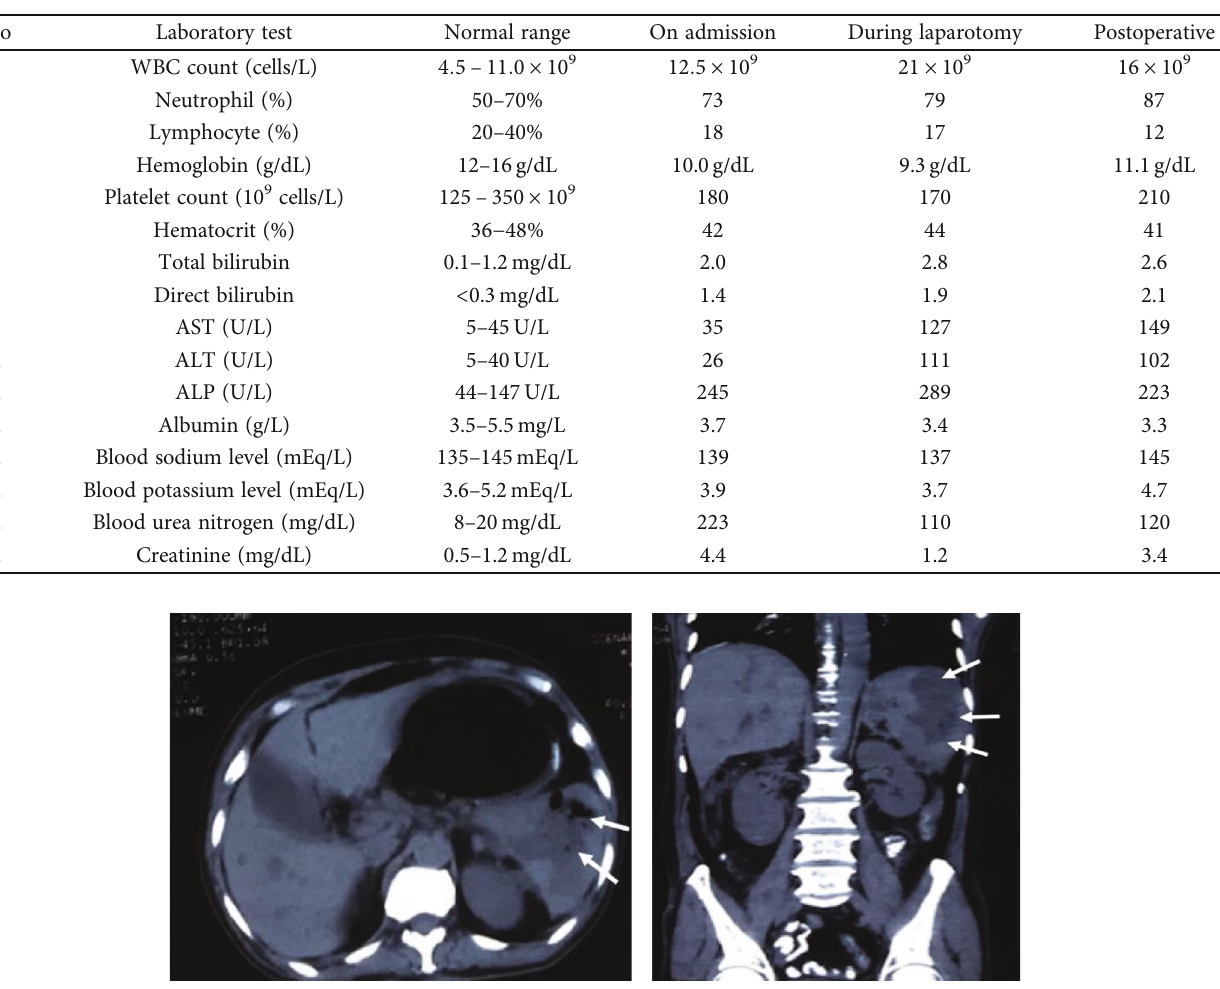
Table 1: Laboratory parameters on admission and during 1 st surgical intervention.